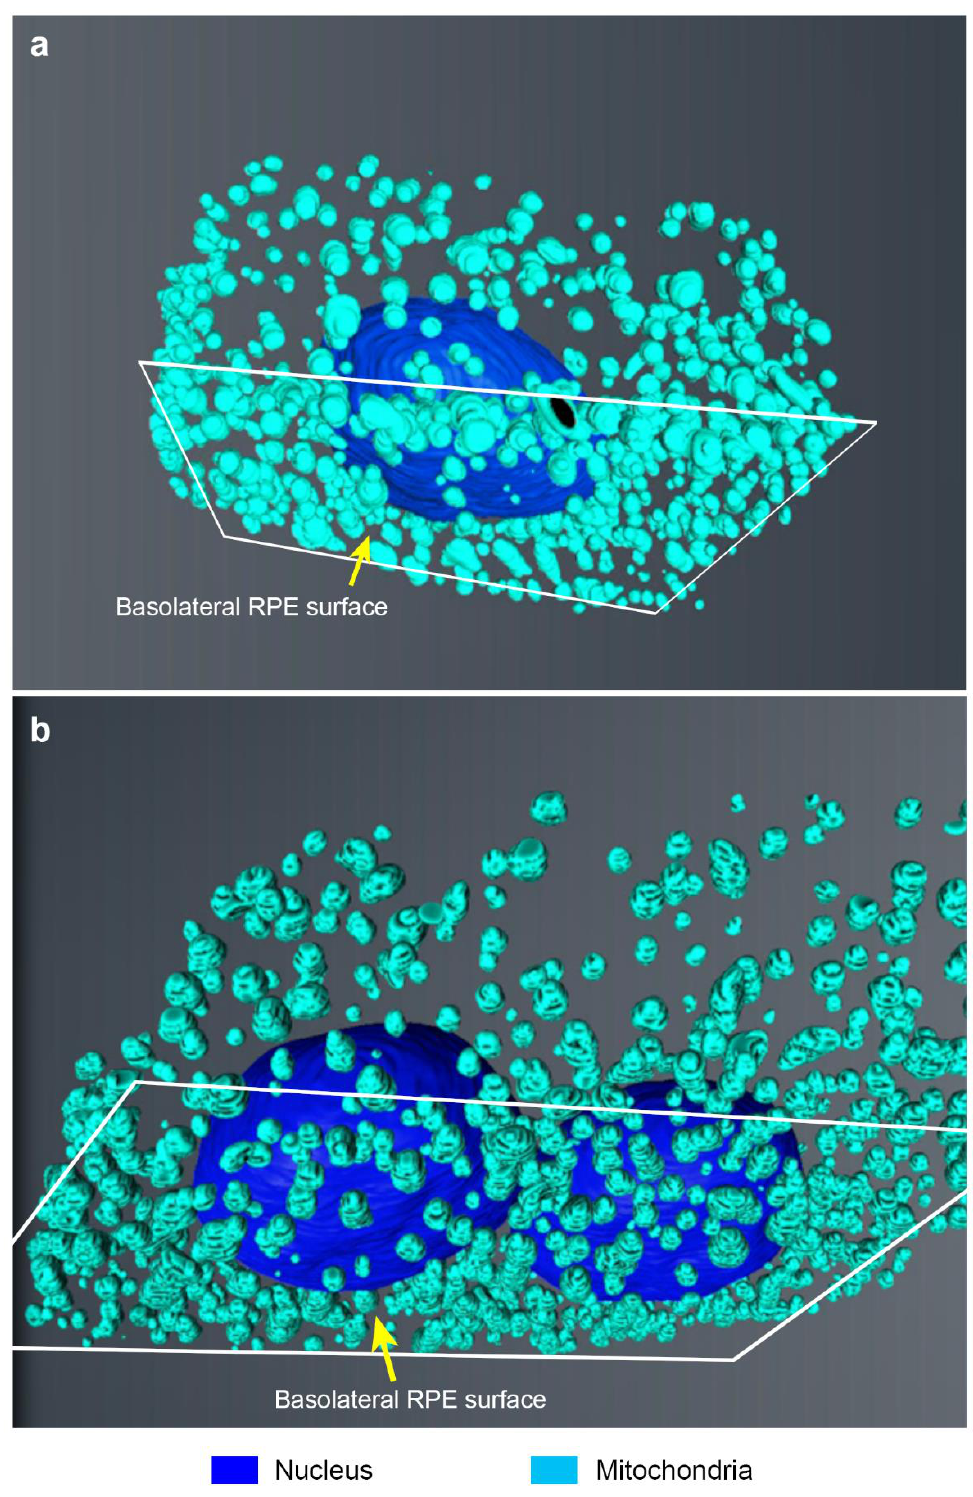
Figure 3. 3D-reconstructed mitochondria in RPE cells. ( a ) View from below the basolateral membrane showing the distribution of mitochondria in mono-nucleate and ( b ) bi-nucleate RPE